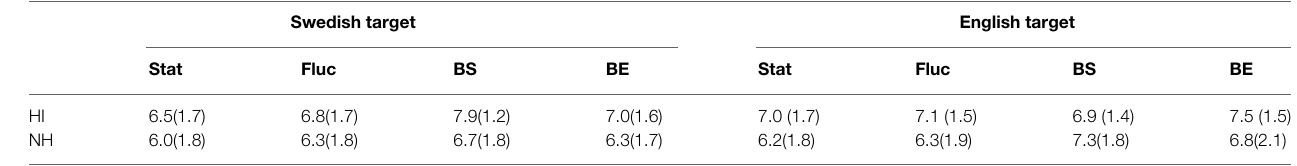
TABLE 1 | The means and standard deviations of the perceived disturbance in the eight different SRT conditions.